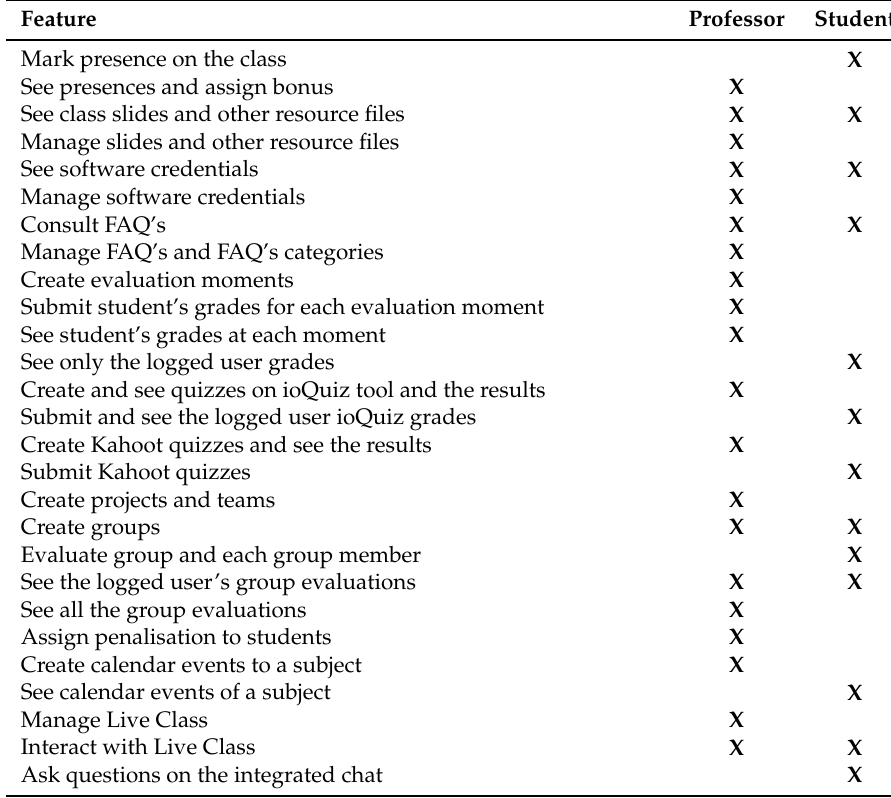
Table 3. ioEduc main features and user access retrieved from